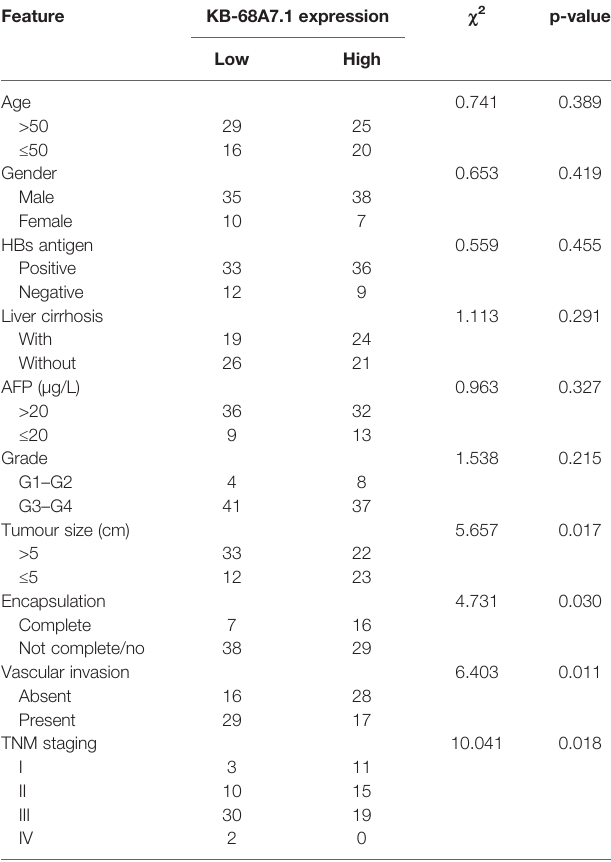
TABLE 1 | Correlation between KB-68A7.1 expression levels and clinicopathological characteristics of 90 HCC patients.